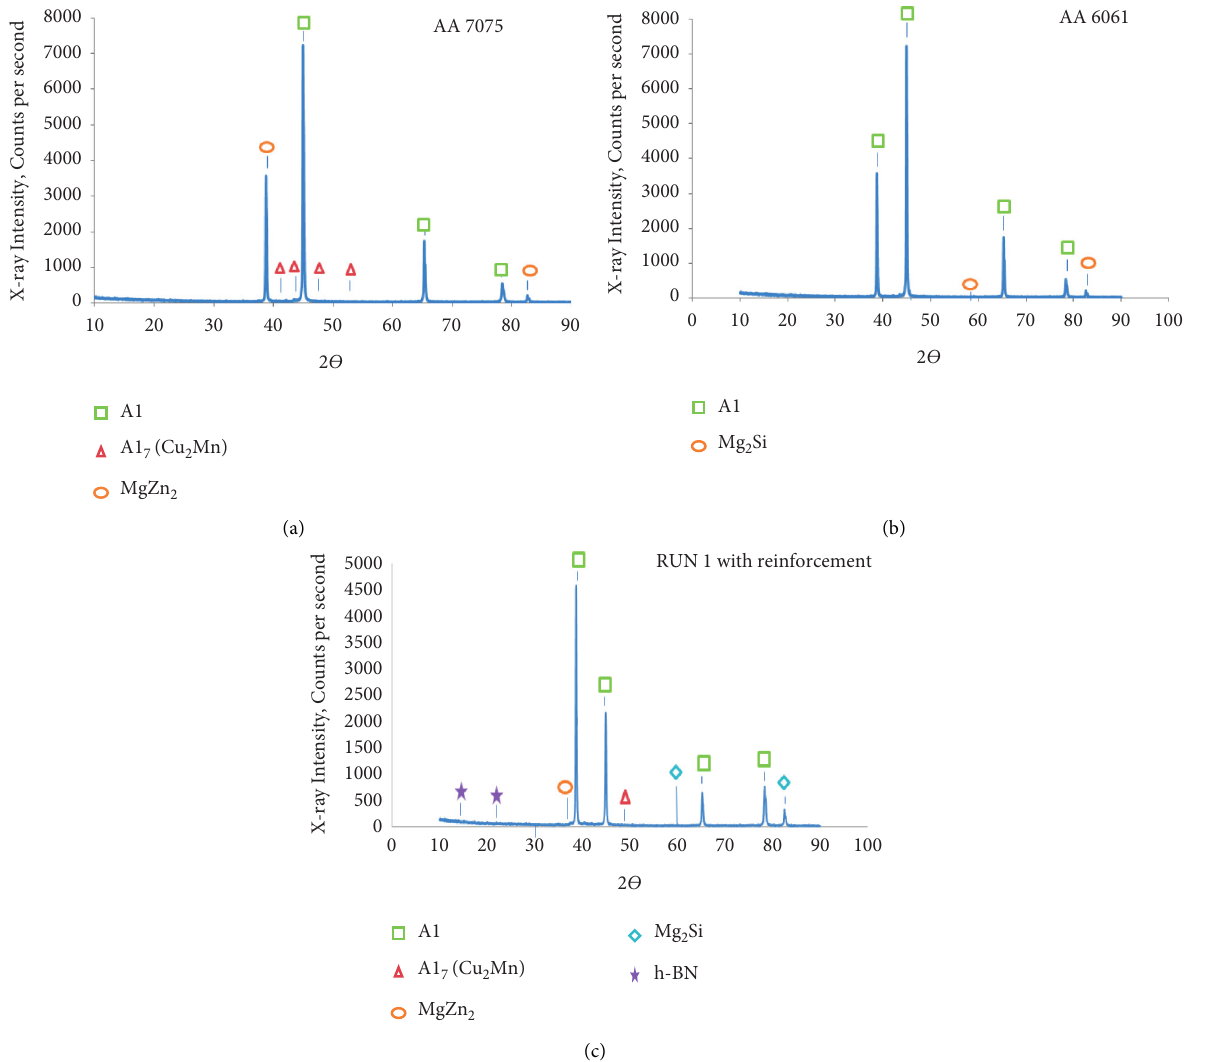
Figure 14: XRD spectrums of (a) AA7075 alloy, (b) AA6061 alloy, and (c) weld with reinforcement.